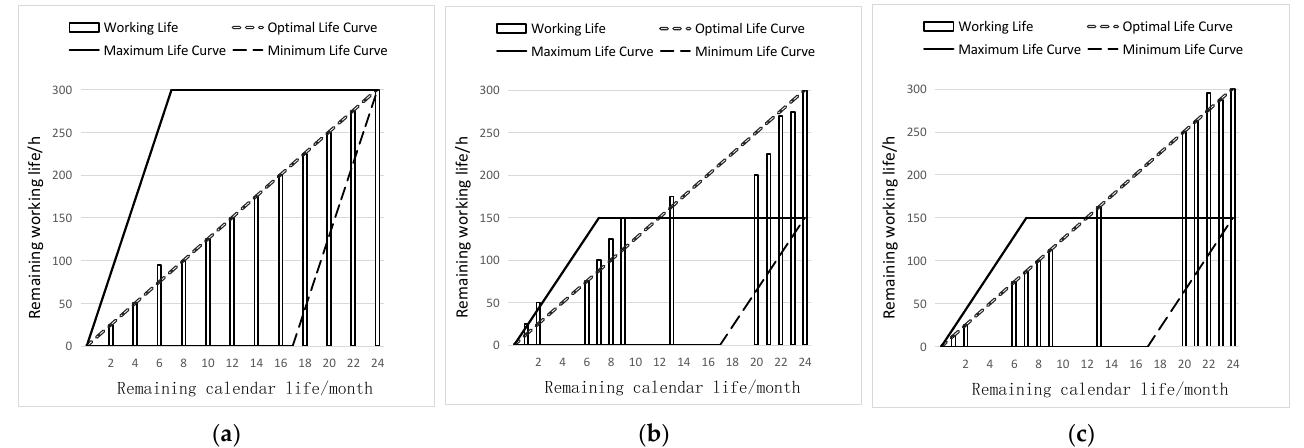
Figure 6. Check of the controllable range of Units 1 – 3. ( a ) Check of Unit 1; ( b ) check of Unit 2; ( c ) check of Unit 3. ( c ) check of Unit